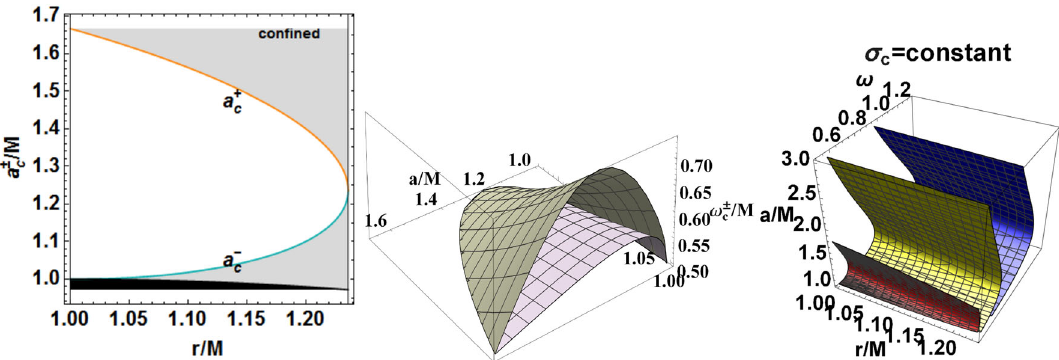
solution σ c = constant for a / M and r / M and frequency ω (blue is for σ = 0 . 1, yellow is for σ = 0 . 3, red for σ = 0 .